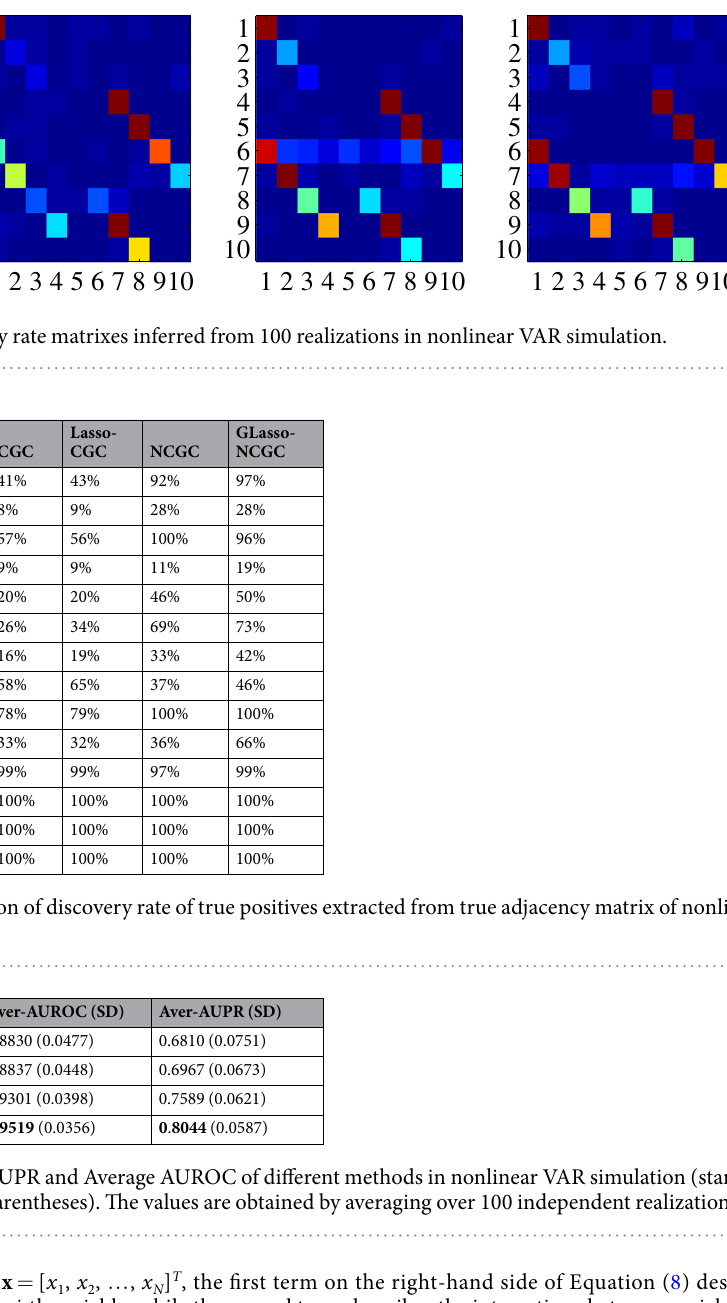
where, t k + 1 − t k = 1. Here, the simulation systems are as follows. S1: Biochemical reaction network (BRN).